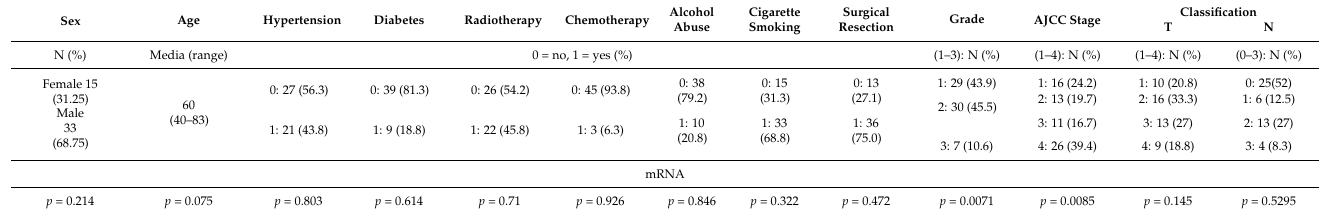
For the group of 68 patients (48 with OSCC + 20 controls, mRNA), the p -value was estimated to find any significant difference in ZNF-281 level according to Grade, AJCC Stage and T and N classifications with the Kruskal–Wallis one-way ANOVA test, whereas that according to other parameters was estimated with the Mann–Whitney U